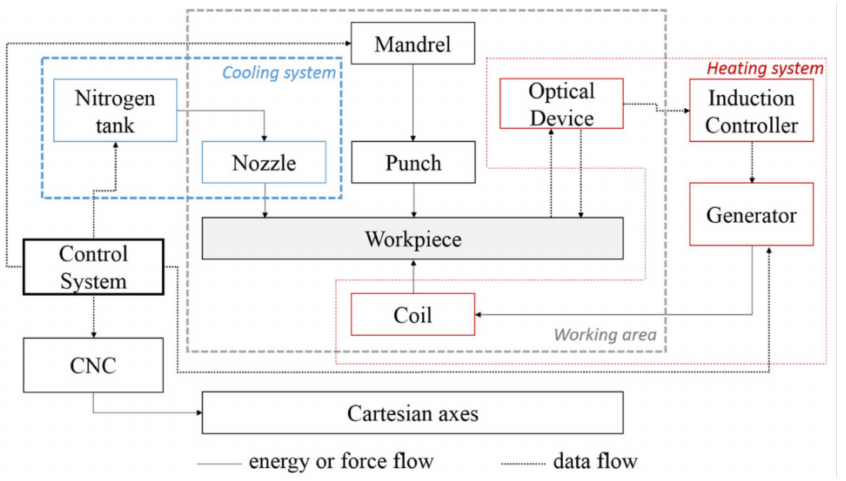
Figure 14. Functional scheme of the experimental equipment (reprinted with permission from [86]; copyright © 2016, Springer-Verlag